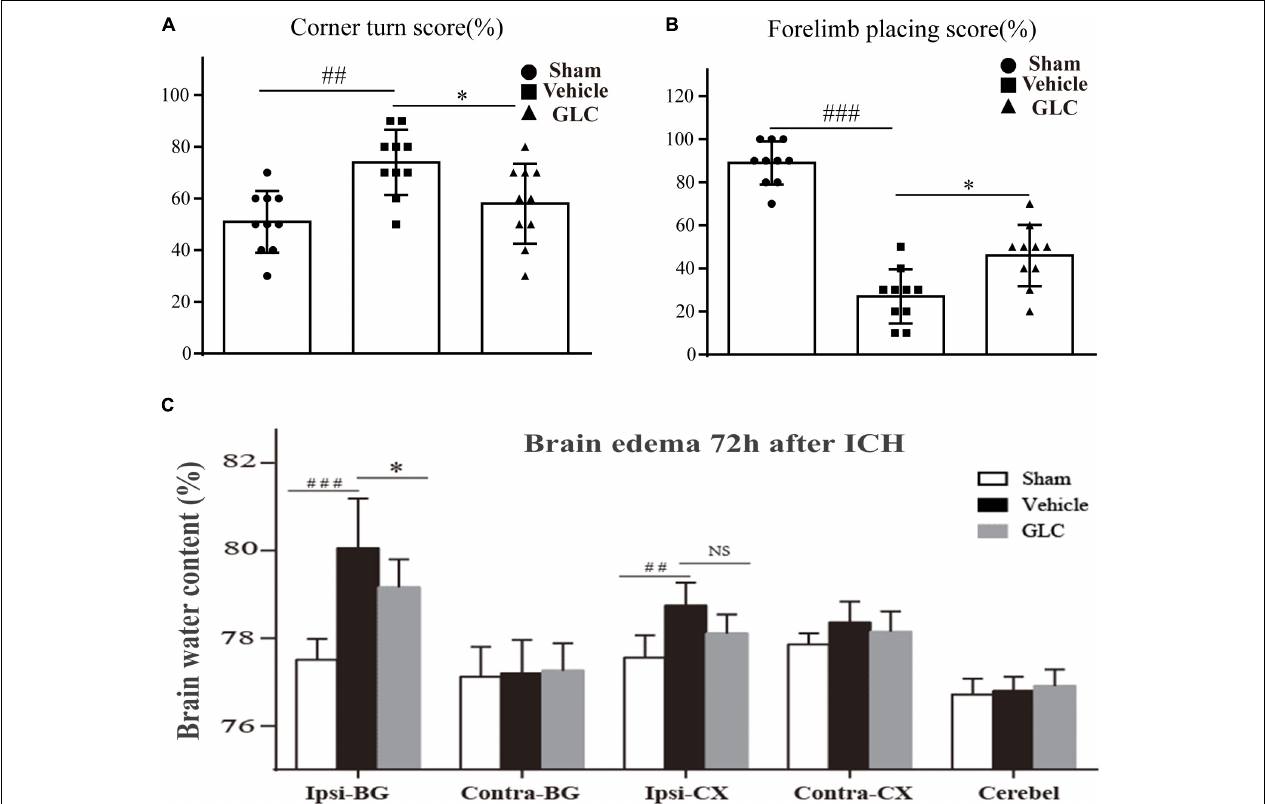
FIGURE 2 | (A) Results of the corner turn test on day 3 after intracerebral hemorrhage (ICH). (B) Results of the forelimb placement test on day 3 after ICH thrombolytic therapy. The results are presented as the mean ± SD. ∗ p < 0.05, ## p < 0.01, ### p < 0.001. (C) Glibenclamide (GLC) significantly reduced ICH-induced brain edema in the ipsilateral basal ganglia (Ipsi-BG) and ipsilateral cortex (Ipsi-CX) 72 h after injury. The cerebellum (Cerebel) served as the internal control. The values are expressed as the mean ± SD, n = 10. Ipsi-BG: vehicle vs. sham ### p < 0.001, vs. GLC ∗ p < 0.05; Ipsi-CX: vehicle vs. sham ## p < 0.01, vs. GLC p >